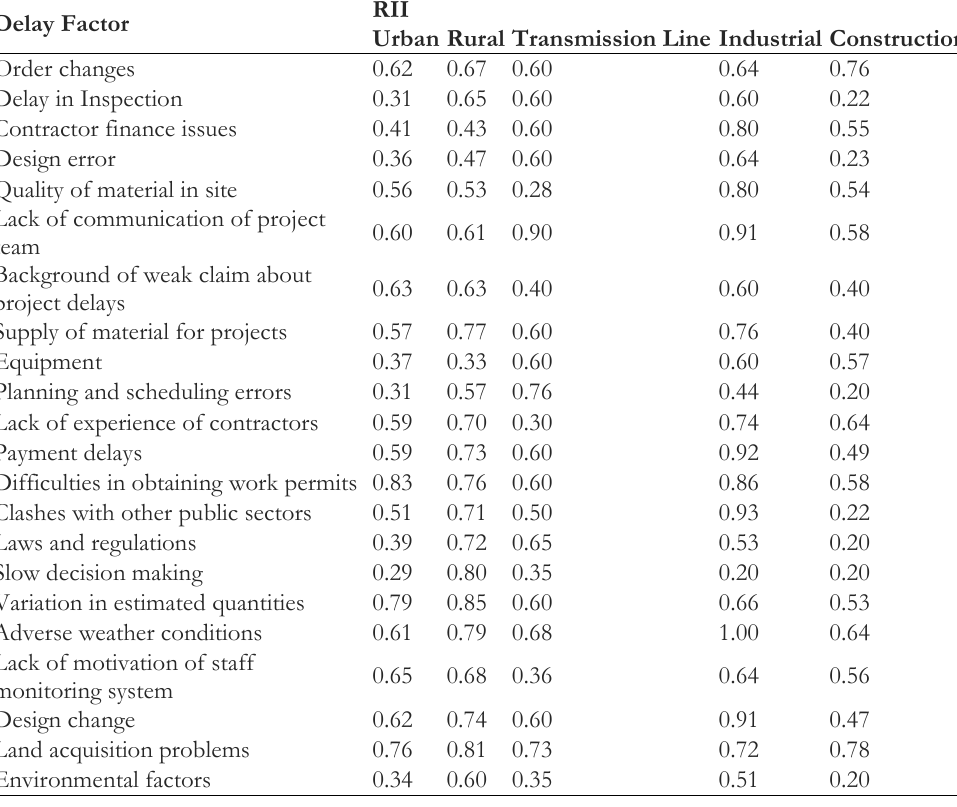
Table 1. RII Calculated for a variety of natural gas distribution